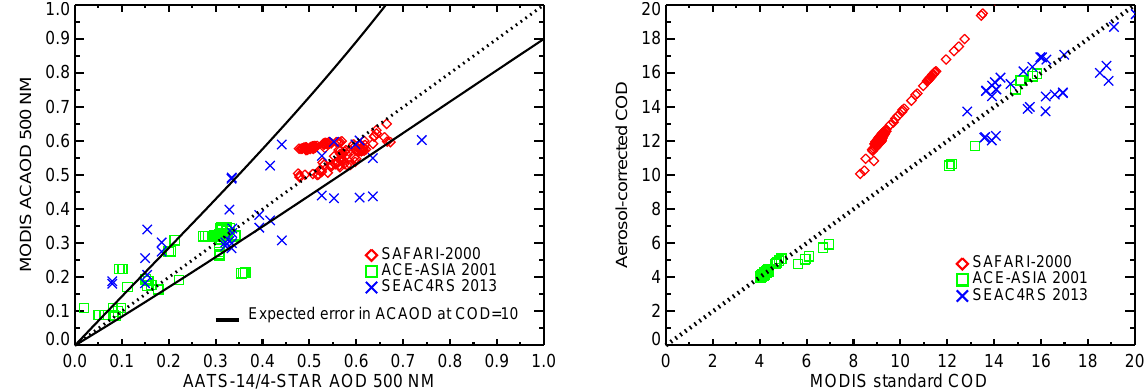
Figure 3. Left: scatter plot of above-cloud AOD retrieved from MODIS ( y axis) and that measured by AATS-6,-14/4STAR ( x axis) for the five events discussed in the text. Right: a comparison of aerosol-corrected COD retrieved from the CR algorithm with those provided by the MODIS standard algorithm